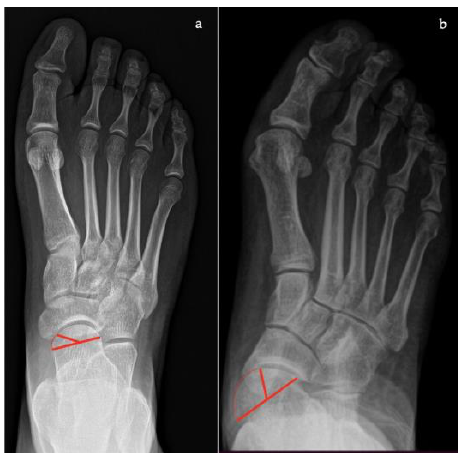
Figure 3. Talonavicular uncoverage percentage (percentage of the talus that is not in contact with the navicular medially). ( a ) Normal foot, <30%; ( b ) pathological flatfoot, >30%.